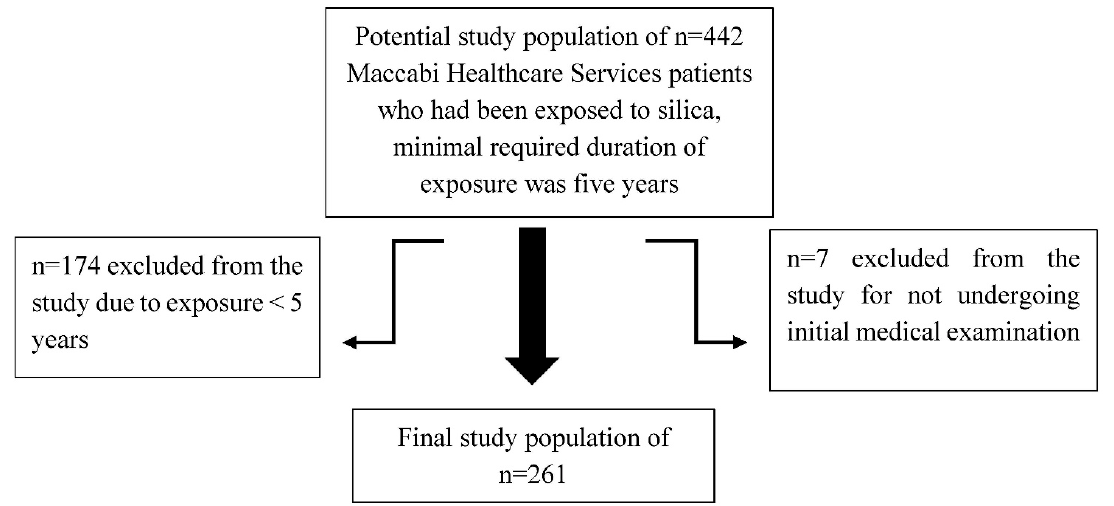
Figure 1. Flowchart of the study selection process.